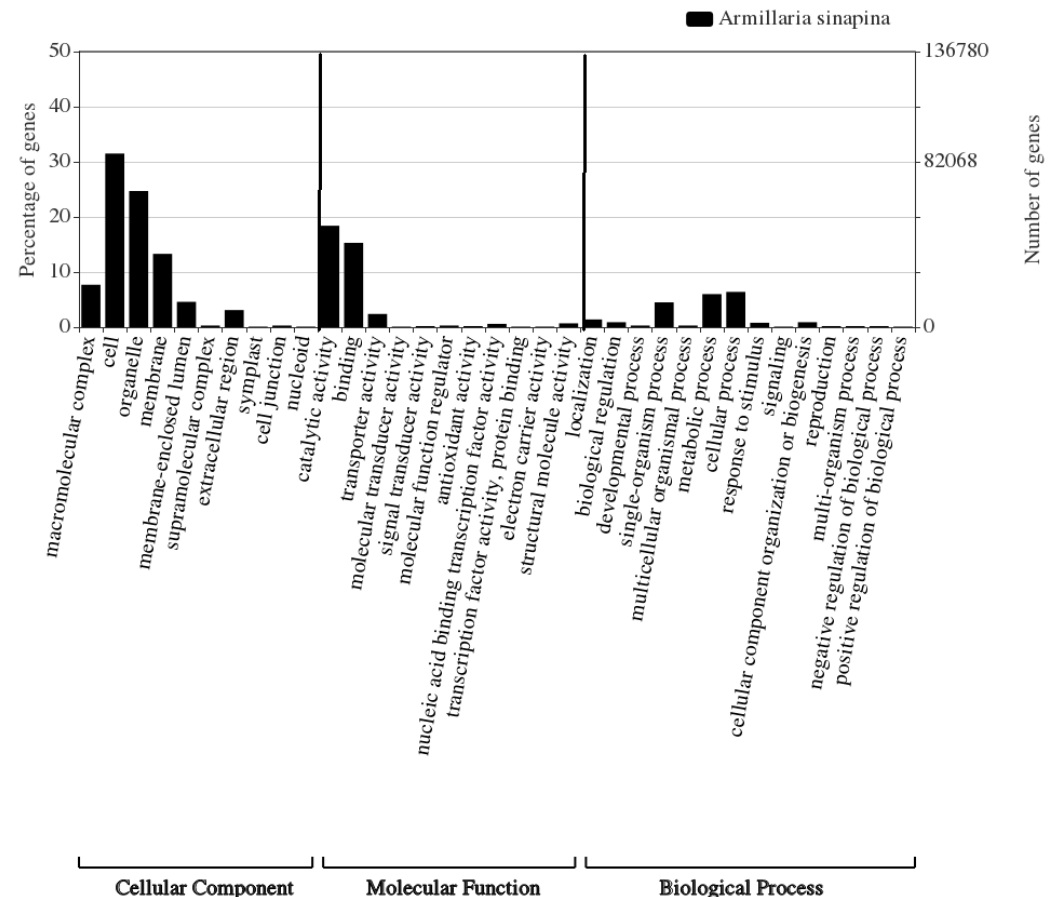
Table 2. Summary of the functional annotation of transcript sequences from A. sinapina obtained from public databases.